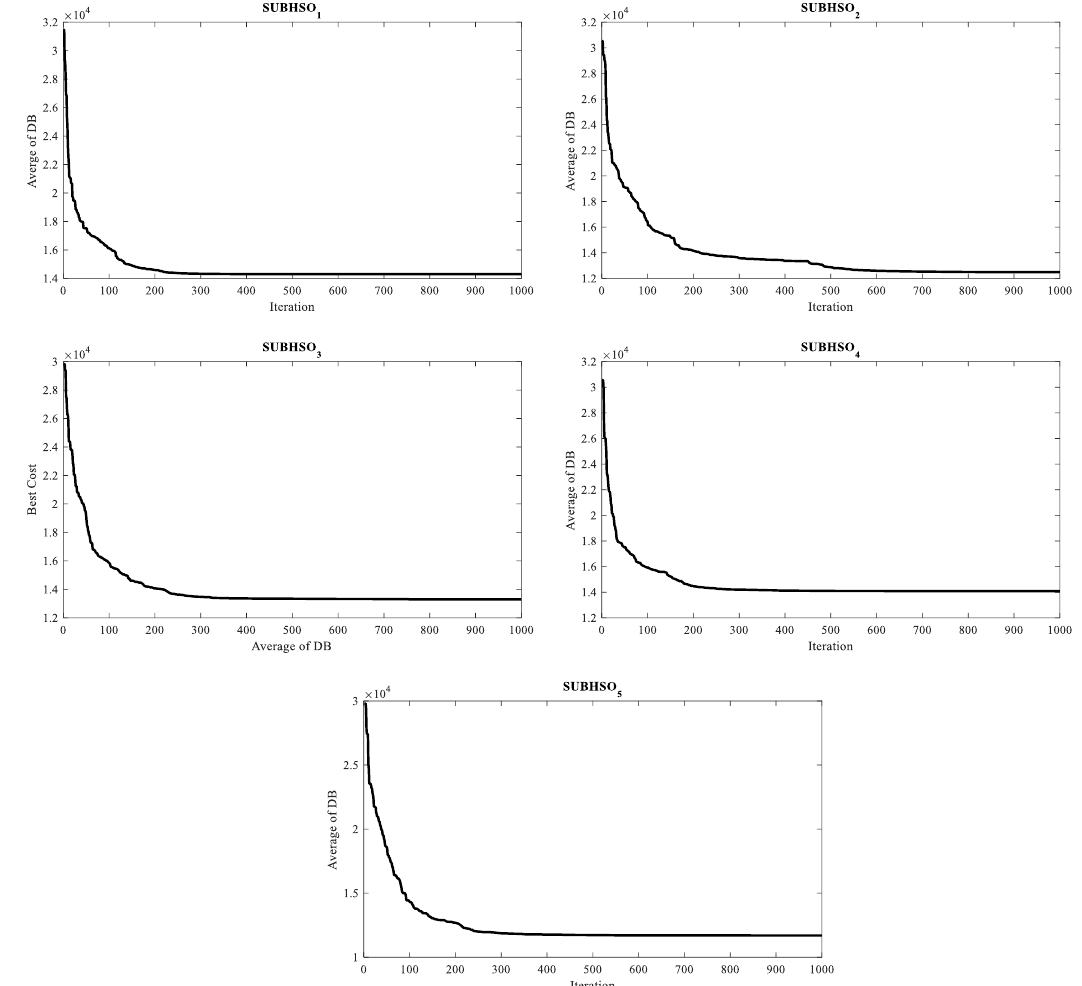
Fig. 10. Graph of optimization of the fitting function values in different branches of the hyper algorithm.